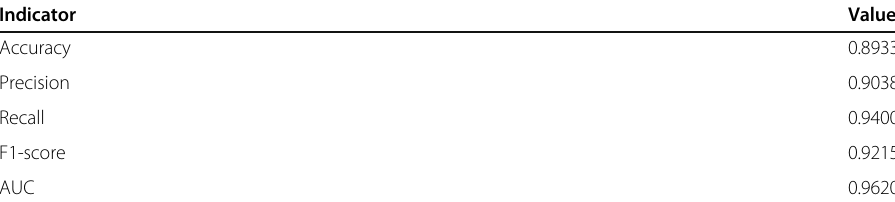
Table 3 Classification performance of the optimal SVM model using the optimal feature subset r (1 : 8)